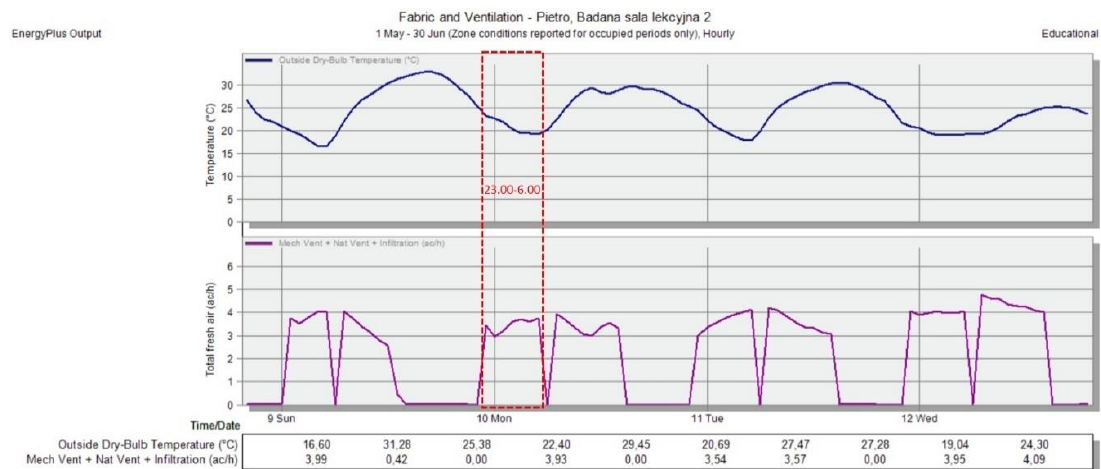
Figure 13. Distribution of outdoor air temperature and intensity of air exchange in natural ventilation (variant 4) for the selected four days, generated in Design Builder program.